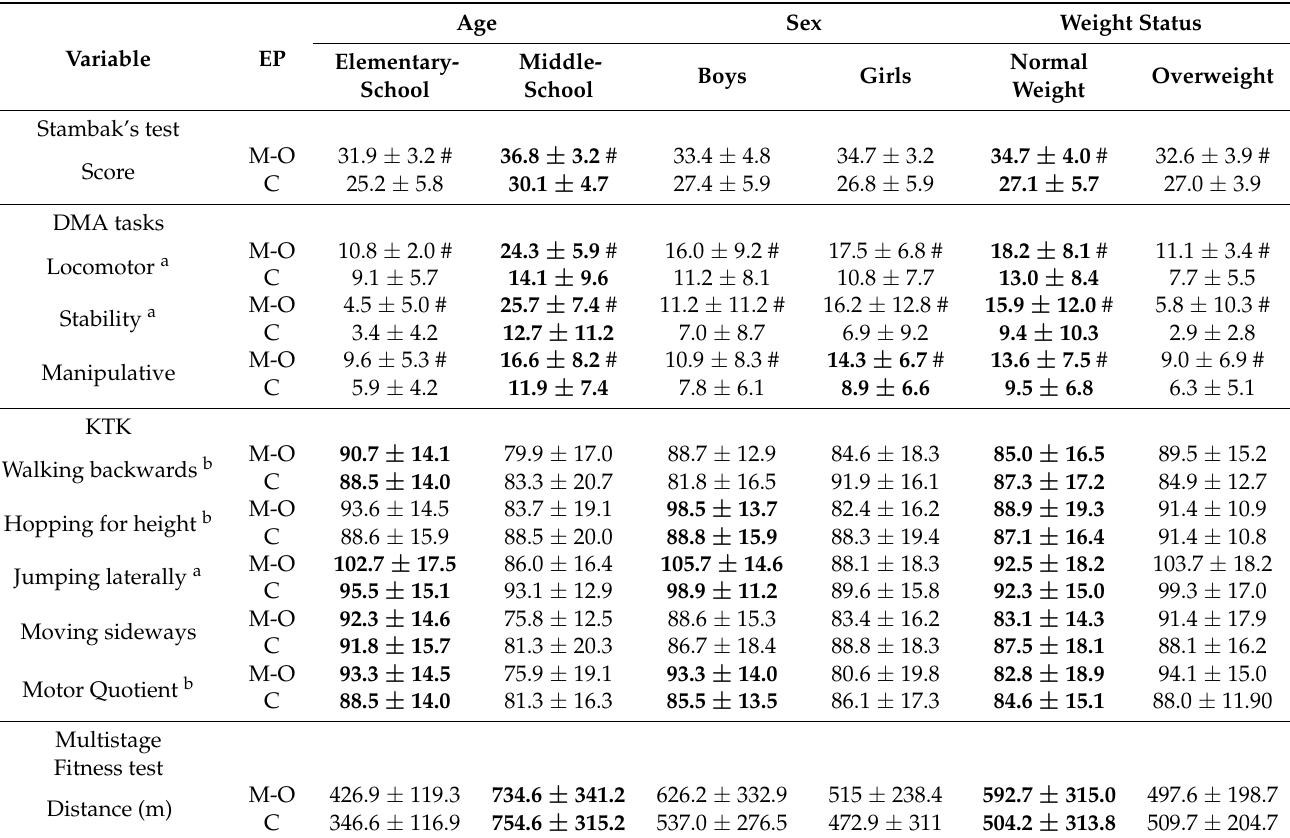
Table 2. Results of testing sessions by age, sex, and weight